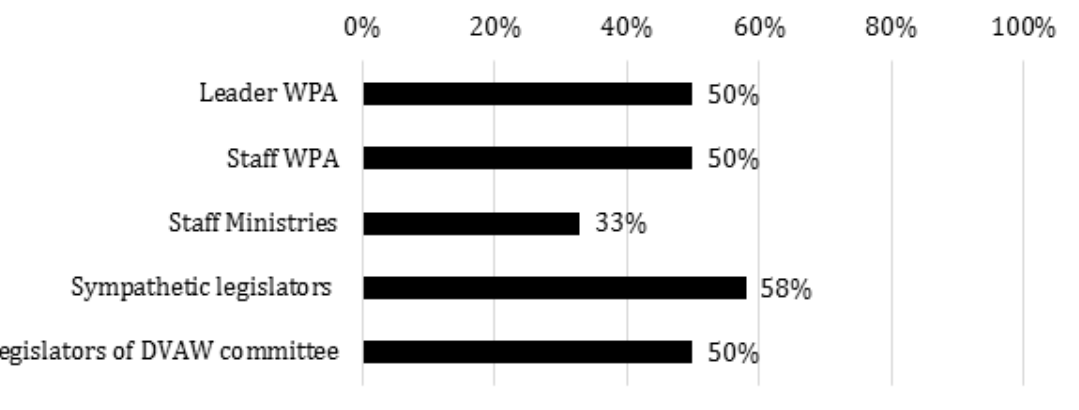
Source: Author’s own